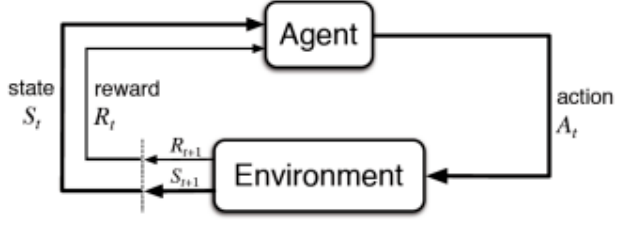
Figure 14. Scheme of the typical agent-environment interaction for reinforcement